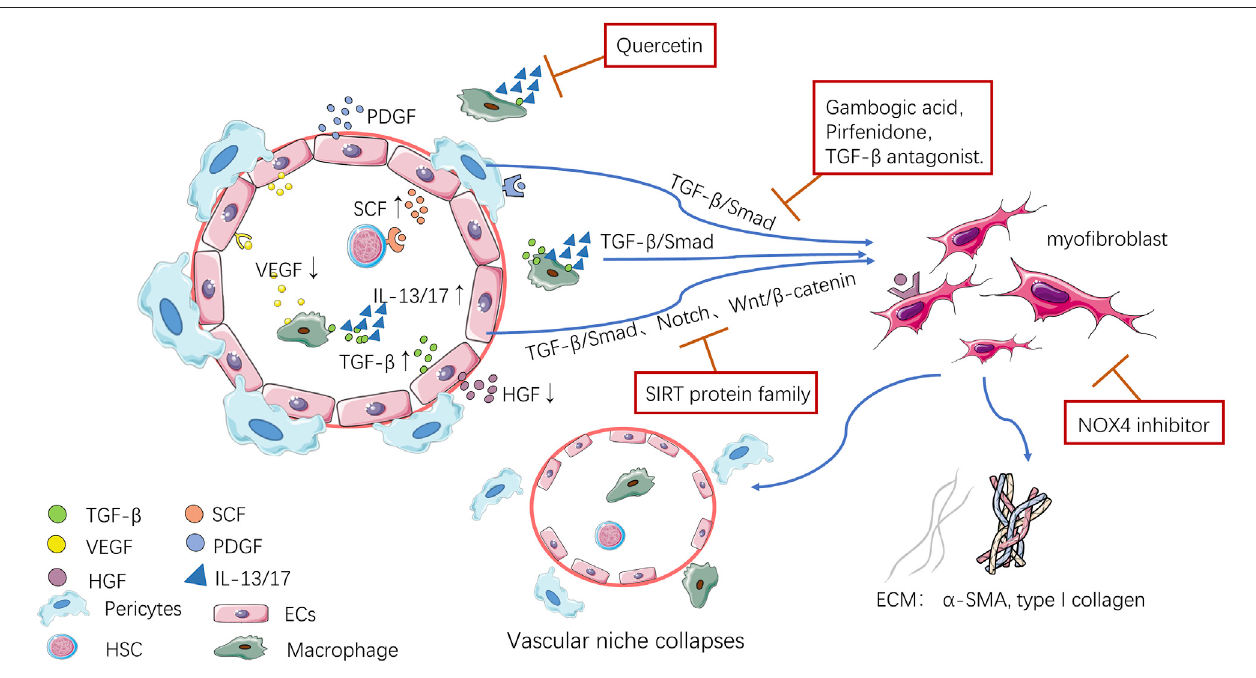
FIGURE 1 | Pathological changes to the vascular